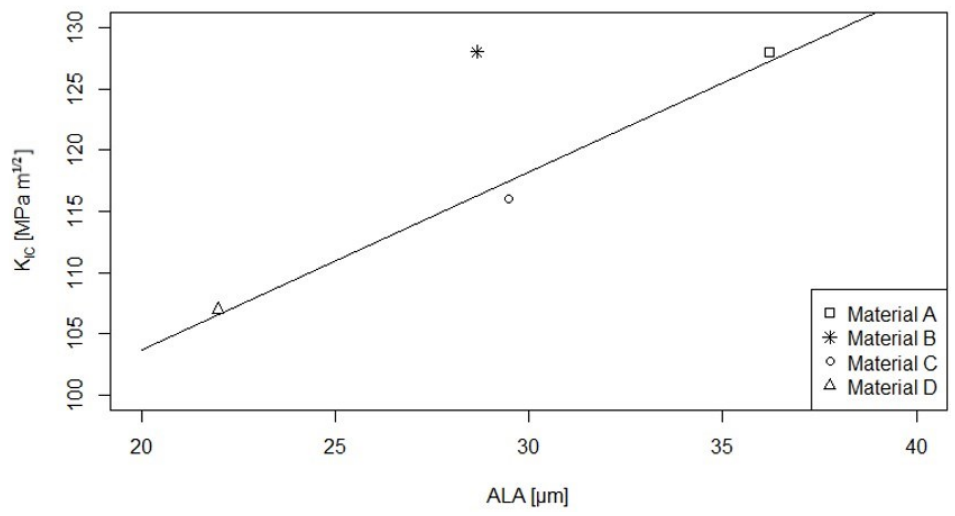
Figure 12. Linear correlation between the microstructural parameter ALA and the fracture mechanical parameter K IC for materials produced via the standard route; the sample from the plastically deformed Material B is marked by an asterisk and does not follow this correlation.